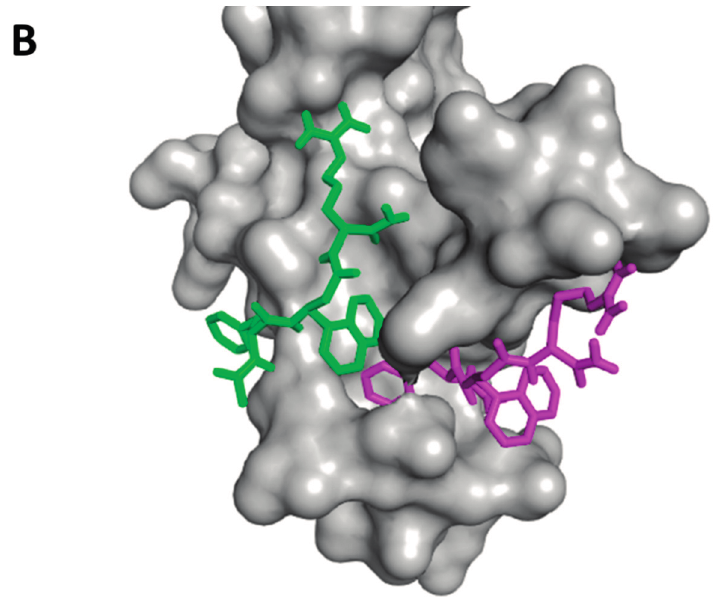
Figure 5. Crystal structure of the HER2 protein (PDB ID: 3N85) [233] extracellular domain IV shown in surface representation. ( A ) Hot-spot region on the surface was identified by FTMAP [150]. Two hot spots were identified; ( B ) Docking of a peptidomimetic designed to bind to domain IV of HER2 protein. The peptidomimetic docked at rank 1 hot spot suggests that hot spots are suitable sites for the design of PPI inhibitors [231]. PyMol (Schrodinger LLC) was used to generate the